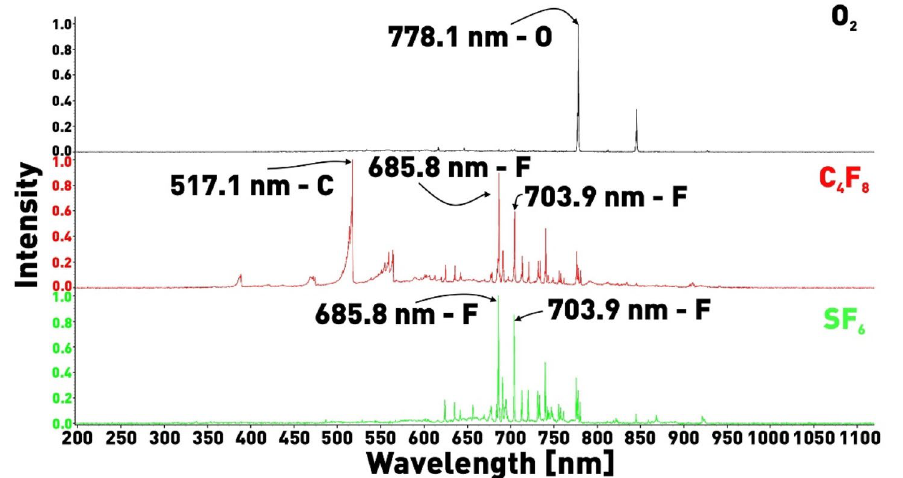
Figure 3. ICP OES of pure O 2 , SF 6 , C 4 F 8 .